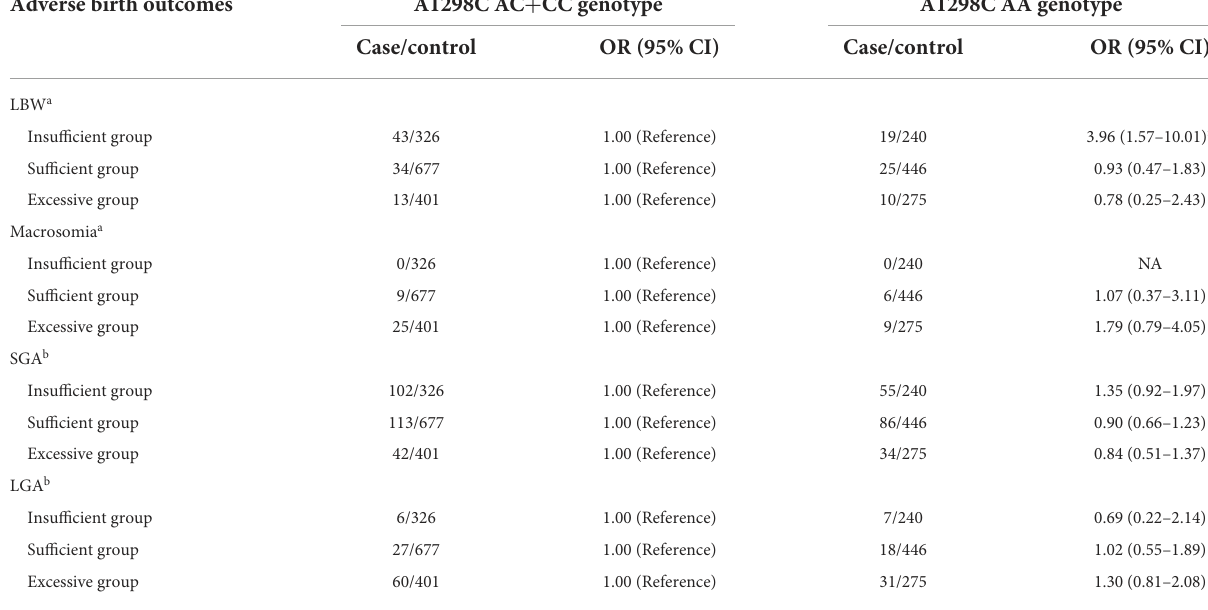
TABLE 5 Associations of MTHFR A1298C polymorphisms and adverse birth outcomes stratified by IOM GWG